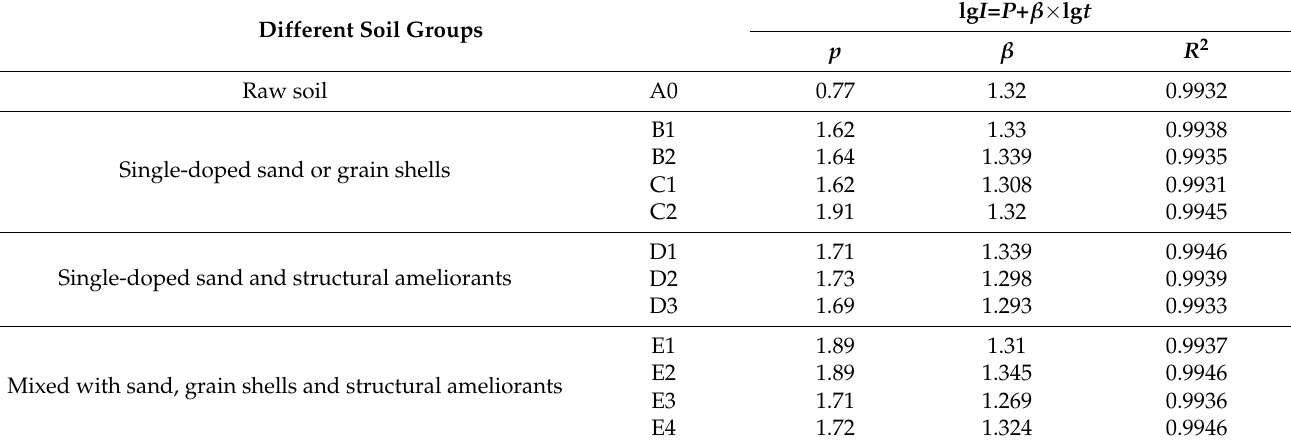
Table 5. Parameters of the Kostiakov infiltration model for different proportions of modified soil. Different Soil